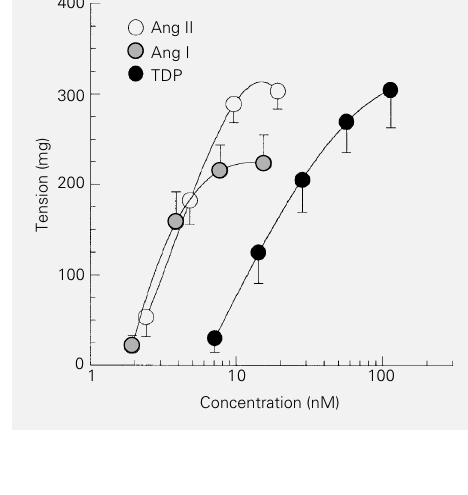
Figure 5 - Contraction induced by angiotensin II (Ang II; 5 nM), angiotensin I (Ang I; 5 nM), and tetradecapeptide (TDP; 19 nM) renin substrate in intact isolated rat aortic rings during a control period and in the presence of [Sar 1 -lle 8 ]Ang II (50 nM) or captropril (36 (cid:181)M). Data are re- ported as mean – SEM and cor- respond to 9, 4, and 5 observa- tions for the control period, [Sar 1 -lle 8 ]Ang II, and captopril, respectively. *P<0.001 com- pared to the corresponding con- trol value (paired